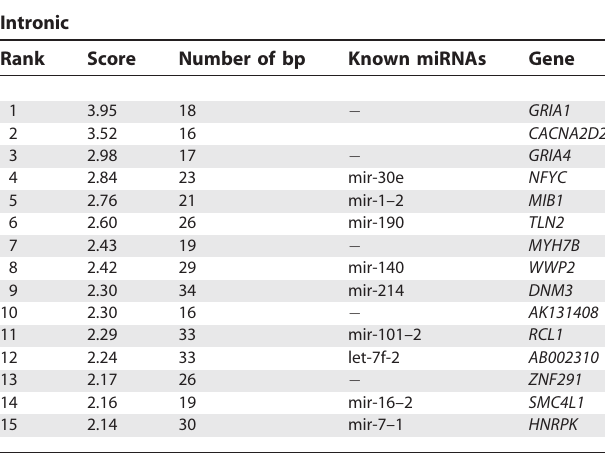
Table 3. Top-Scoring Long-Intronic